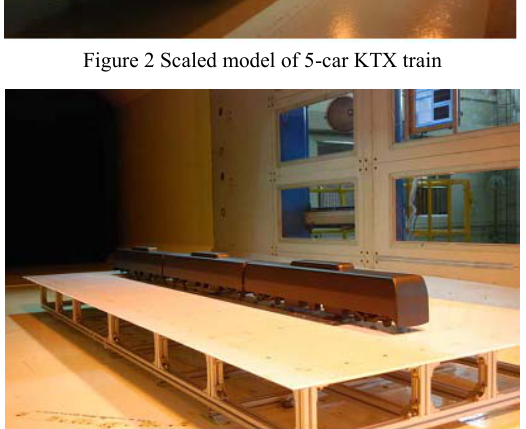
Figure 3 Scaled model of 3-car AREX